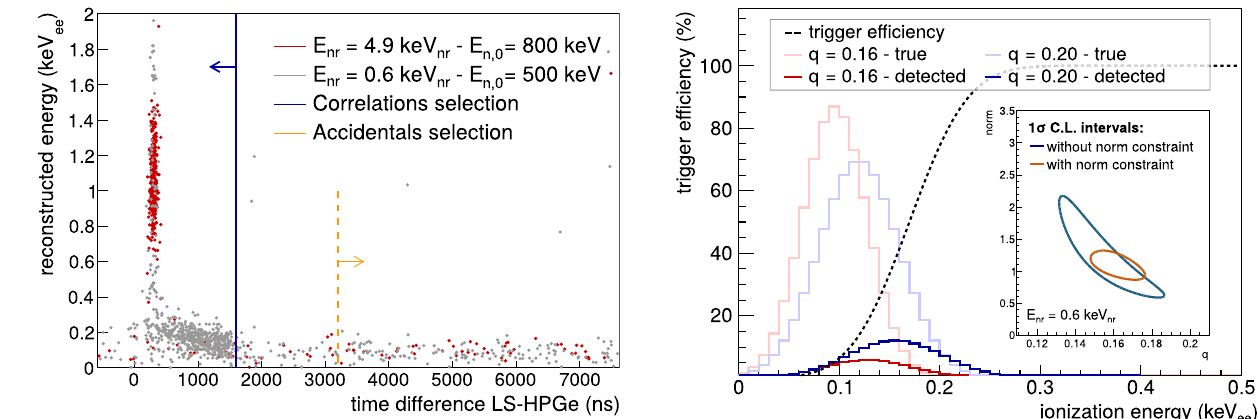
Fig. 10 Illustration of trigger efficiency effects for an initial recoil energy of 0.8keV nr under the assumption of an ionization quenching factor q of 0.16 (red) or 0.20 (blue). The “detected” distributions are obtained by convolving the “true” distributions with the HPGe detec- tor response, including the energy resolution and the effects of trigger efficiency and energy scale non-linearities discussed in Sect. 2.3. In particular, if the trigger efficiency is not taken into account properly, this can lead to apparent non-linearities in the energy scale and biased results in terms of ionization quenching factor. Due to the poor dis- crimination between the detected shapes, rate and ionization quenching factor strongly anti-correlate at these energies. This is illustrated by the blue 1 σ contour in the inset plot obtained when fitting the low energy coincidence data distribution without any norm constraint. The addition of the norm constraints summarized in Table 2 clearly provides a sensi- tivity improvement and allows to reduce the statistical uncertainties on q by about a factor 2 as shown by the corresponding orange